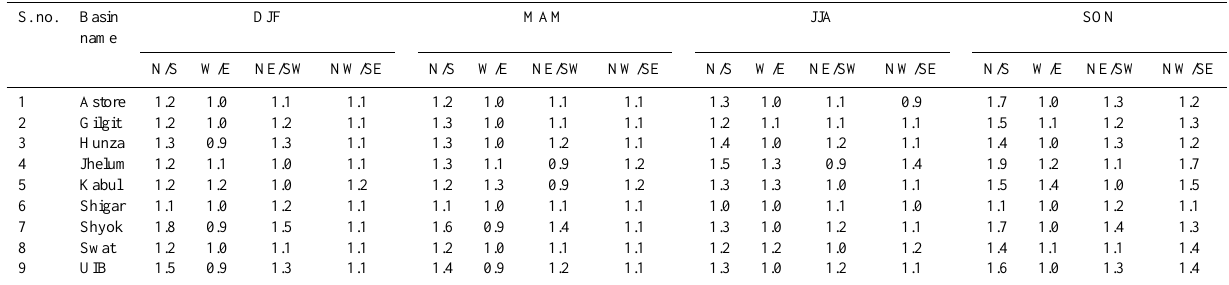
Table 8. Seasonal aspect ratios of snow coverage for all the study basins. S. no. Basin DJF MAM JJA SON name